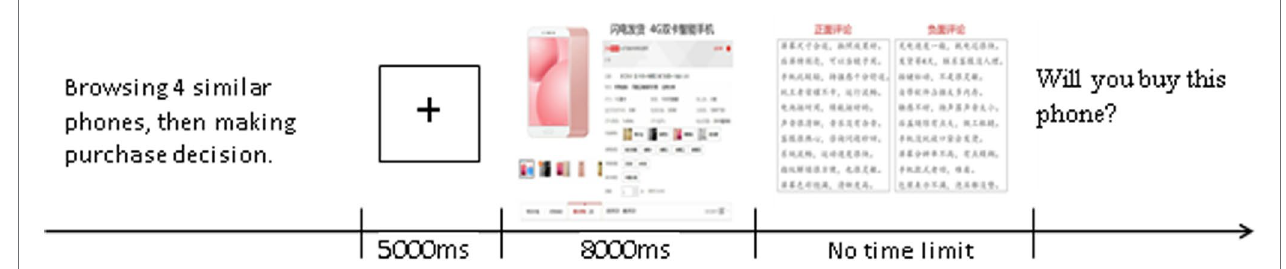
FIGURE 3 | Experimental flow diagram. Screenshots of Alibaba shopfront reproduced with permission of Alibaba and Shenzhen Genuine Mobile Phone Store.